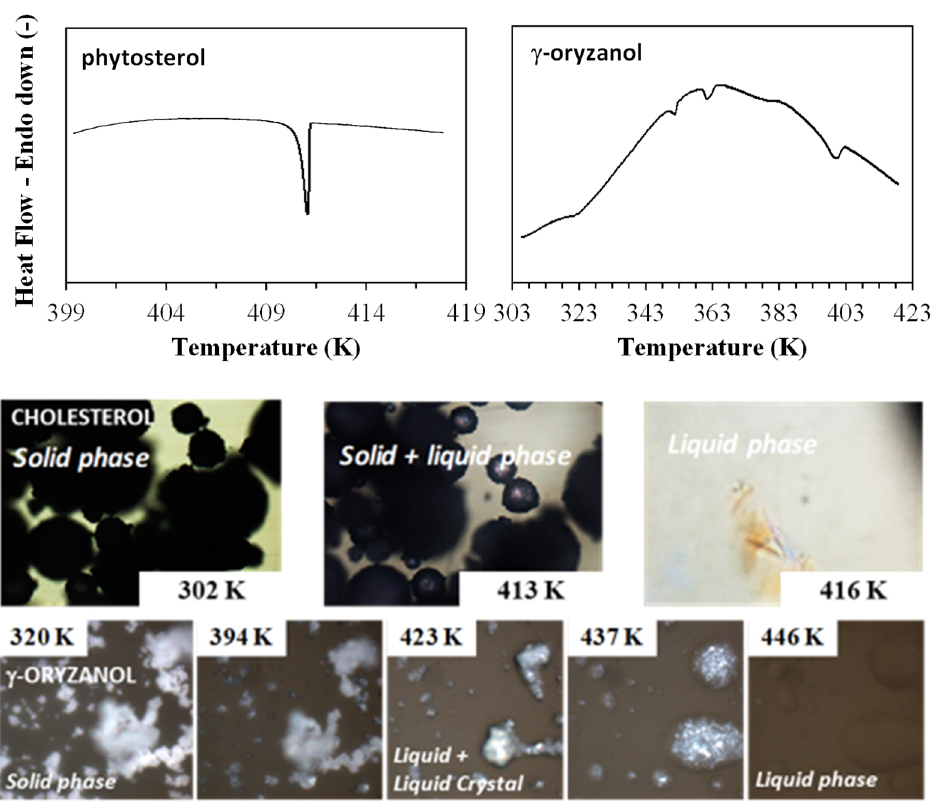
Figure 2. DSC thermograms for phytosterol and γ -oryzanol melting process and images obtained by POM for phytosterol and γ -oryzanol melting process.